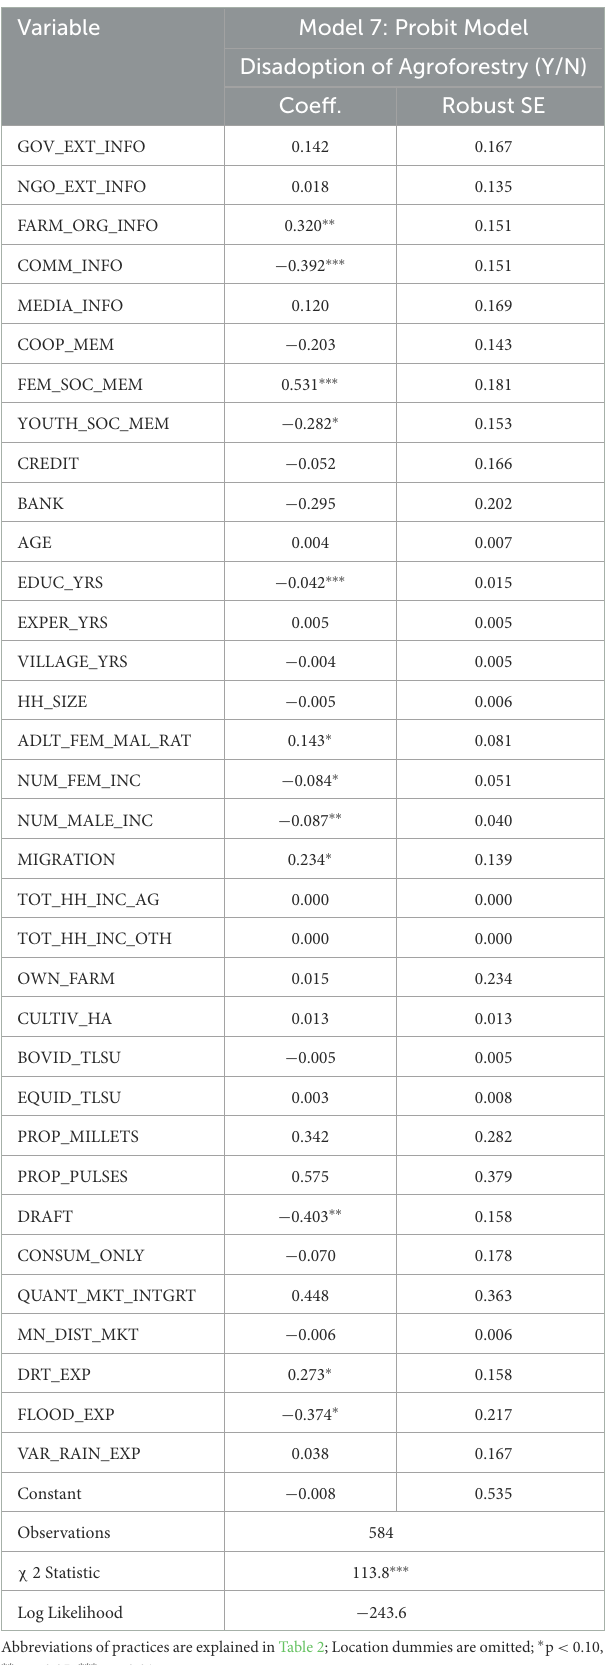
TABLE 7 Model estimates for disadoption across all four Mali